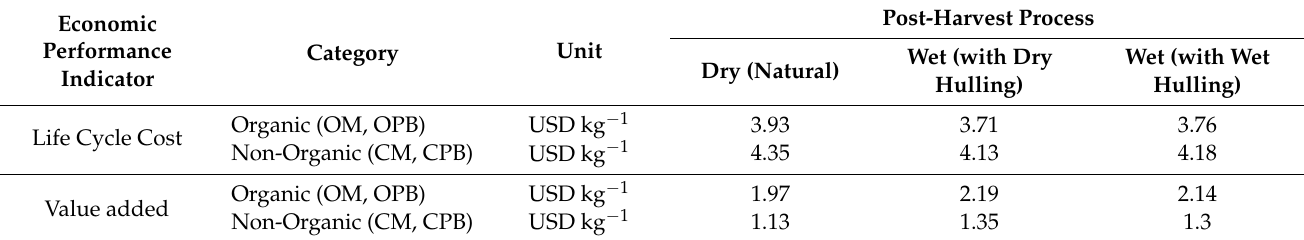
Table 5. Economic performance for 1 kg of green production in the post-harvest